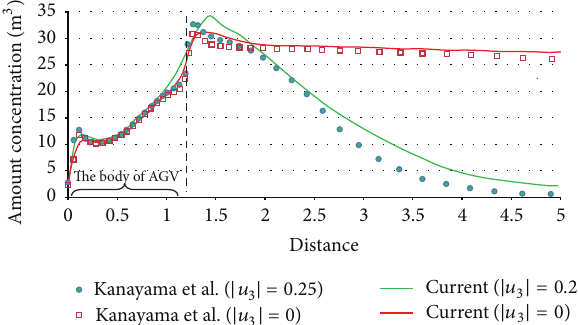
Figure 11: Contaminants